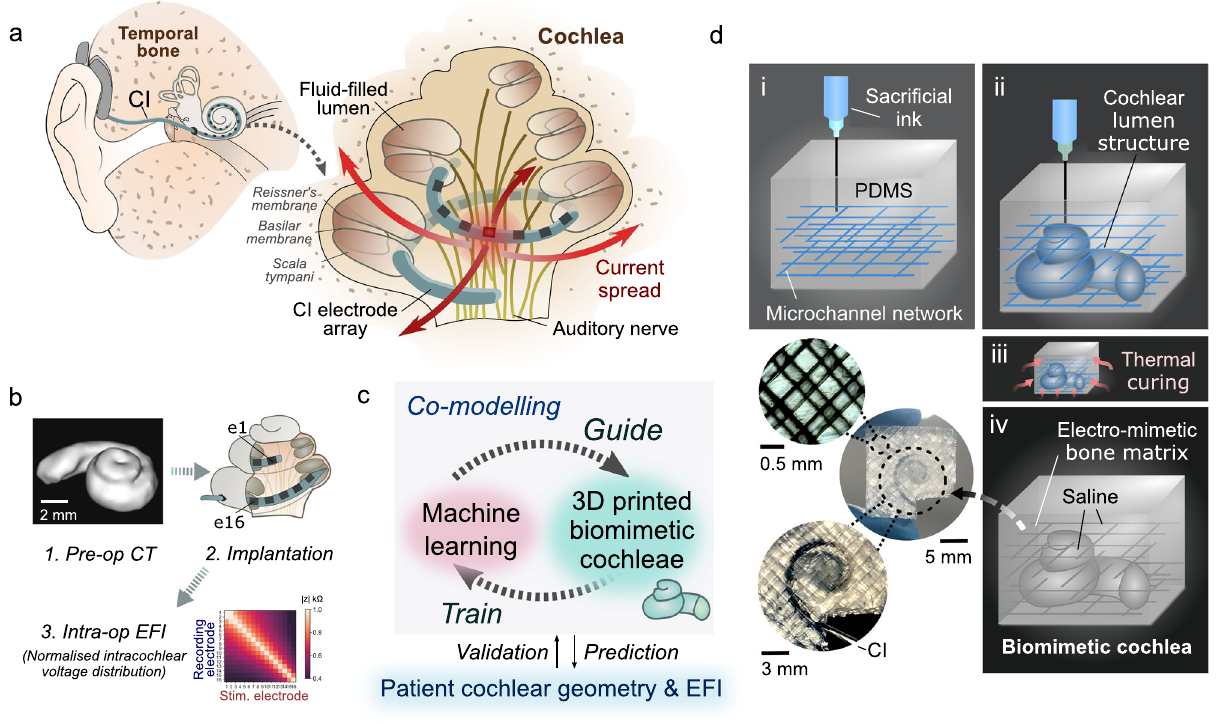
Fig. 1 3PNN co-modelling approach with embedded 3D printing of biomimetic cochleae for reproducing the CI stimulus spread characteristics. a Schematic of the auditory system and the cochlea with a CI implanted. The ‘ current spread ’ problem induced by a stimulating electrode of the CI electrode array is indicated. b Schematic of the routine CI assessment process; 1 . Preoperative CT scan of a patient ’ s cochlea, which typically only has suf fi cient resolution to reveal the ensemble spiral-shaped cavity of a cochlea; 2 . Implantation of the electrode array of a CI in the scala tympani of the cochlea; 3 . Acquisition of an intra-operative EFI (electric fi eld imaging) pro fi le from a patient, which is derived from recording the induced intracochlear voltage V measured at each electrode upon injecting consecutive current pulses at each electrode in the array. The voltage measurements are then converted to transimpedance magnitude | z | by normalising the voltage V with the stimulation current impulse I stim (|z| = V/I stim ) . The off-stimulation (off-diagonal) measurements in the EFI present information about the tissue impedance 9 . c Overview of the 3PNN co-modelling framework for providing clinical informatics. d Schematic of the embedded 3D printing strategy to produce the electro-mimetic bone matrices and the biomimetic